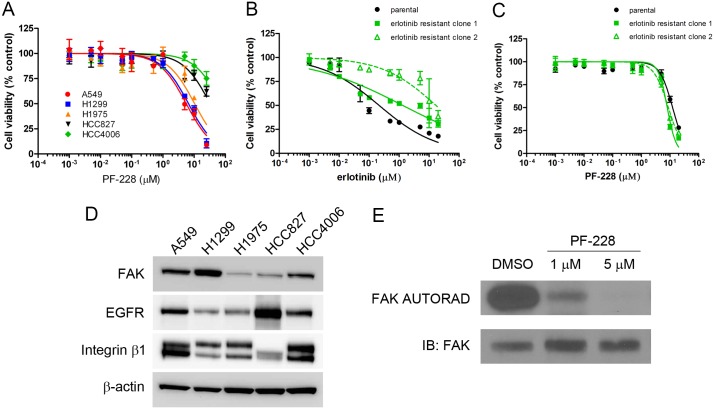
Inhibition of FAK reduces cell viability of EGFR TKI-resistant NSCLC cells.(A) Cell viability was assessed following treatment with PF-228 at varying doses for 48 hours in complete media with 5% FBS. Cell viability was assessed by MTT assay with the viability of DMSO-treated cells set as 100%. Data indicates the mean ± SEM for log[inhibitor] vs. normalized response from two independently performed experiments. (B) HCC4006 cells serially grown in increasing concentrations of erlotinib up to 3 μM were confirmed resistant compared to parental cells following MTT assay of cells treated with increasing concentrations of erlotinib. Data is graphed as the mean of log[inhibitor] vs normalized response ± SEM (N = 2). (C) Erlotinib resistant HCC4006 cells are more sensitive to FAK inhibitor PF-228 than parental HCC4006 cells. Cells were treated with increasing concentrations of PF-228 and cell viability was assessed by MTT assay. Data is presented as the mean of log[inhibitor] vs normalized response ± SEM (N = 2). (D) Relative protein expression between erlotinib resistant (A549, H1299, H1975) and sensitive (HCC827, HCC4006) parental cell lines. (E) A549 cell lysates were immunoprecipitated for endogenous FAK and subjected to in vitro kinase assays in the presence of either DMSO (vehicle control) or PF-228 (1 μM or 5 μM). Autoradiography revealed FAK phosphorylation (FAK AUTORAD) and western blotting indicated total levels of FAK (IB: FAK).